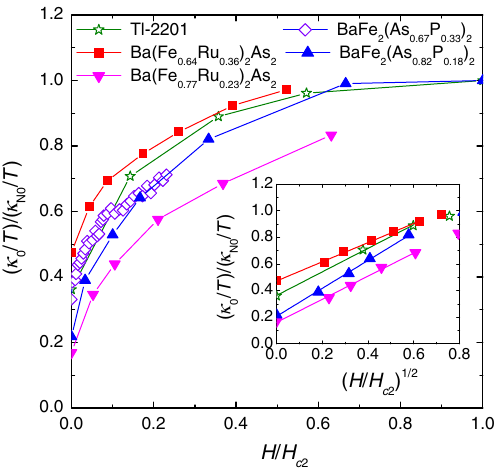
FIG. 4. Normalized residual (cid:1) 0 =T of Ba ð Fe 0 : 64 Ru 0 : 36 Þ 2 As 2 (called sample OP20K in the paper), Ba ð Fe 0 : 77 Ru 0 : 23 Þ 2 As 2 (sam- ple UD17K), and BaFe 2 ð As 0 : 82 P 0 : 18 Þ 2 (sample UD4K) as a function of H=H c 2 . Similar data of an overdoped d -wave cuprate superconductor Tl-2201 [33], and BaFe 2 ð As 0 : 67 P 0 : 33 Þ 2 [16] are also shown for comparison. The behaviors of (cid:1) 0 ð H Þ =T in OP20K, UD17K, and UD4K clearly mimic the behaviors in Tl-2201 and BaFe 2 ð As 0 : 67 P 0 : 33 Þ 2 . Inset: the same data points for OP20K, UD17K, UD4K, and Tl-2201 are plotted against Þ 1 = 2 . The lines represent the H 1 = 2 ð H=H c 2